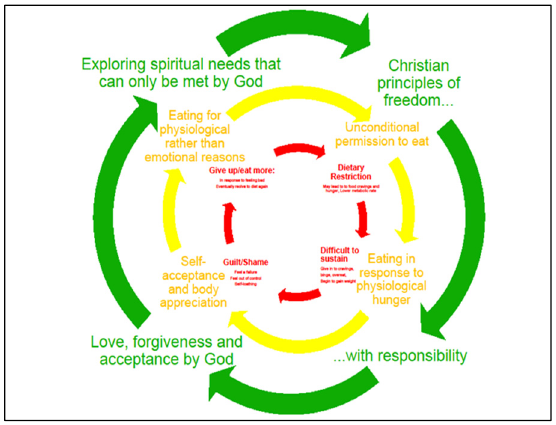
Figure 1. Theoretical underpinning of the Taste and See Programme.